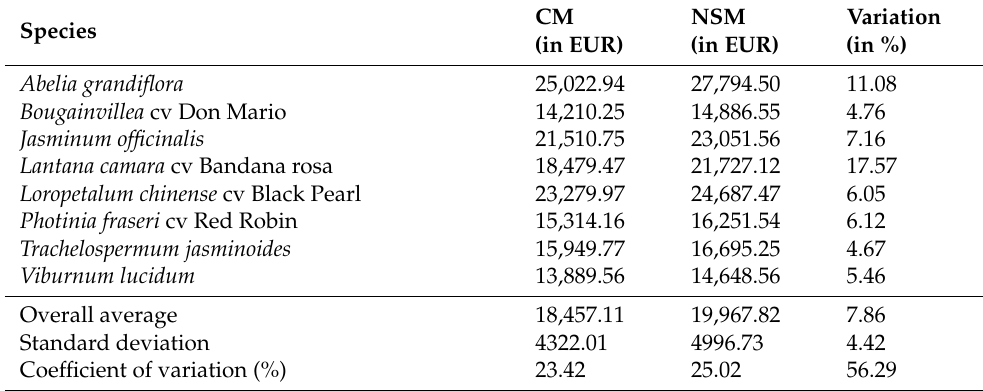
Table 12. Net present value (NPV) variation for two production models: conventional production model (CM) and novel and sustainable production model (NSM), among 8 selected ornamental species. A discount rate of 5% was used for both protocols, even if the production with NSM presumes a reduction in the risk of production of safer phytosanitary ornamental plants. The label values (in %) indicate the variation in NPV between the two